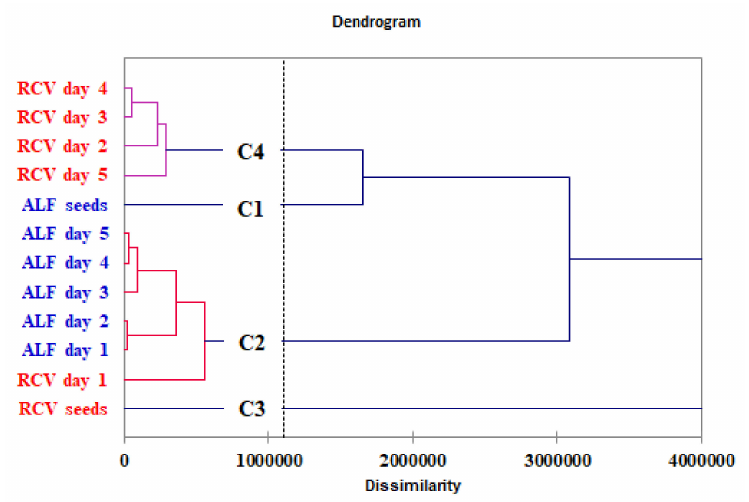
Figure 4. Dendrogram of the 12 objects (alfalfa and red clover sprout samples) represented by phenolic compounds’ profile obtained by Ward’s hierarchical clustering method (hierarchical cluster